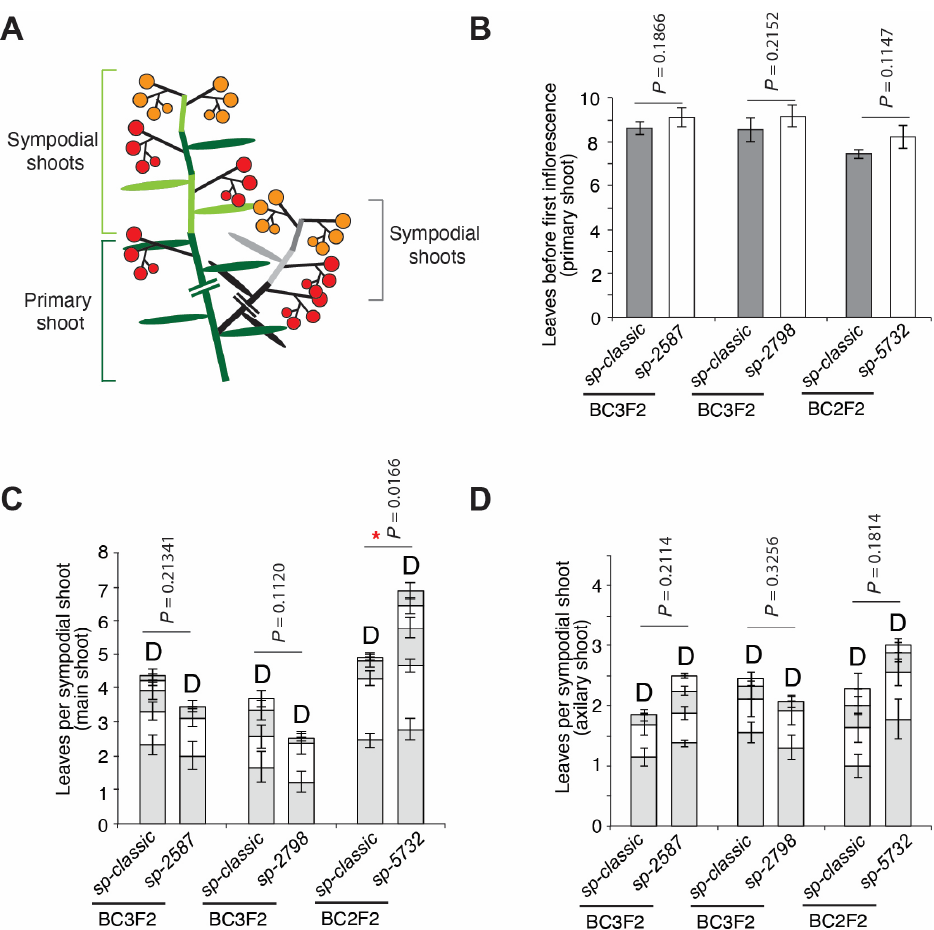
Figure 4. Comparison of flowering time with leaf numbers on the primary and sympodial shoot among sp alleles. ( A ) Diagrams depicting sympodial shoot growth on the main and axillary shoot in determinate tomato. Alternating dark green and light green bars represent the primary and successive sympodial shoots in main shoot. Alternating black and gray bars indicate the successive sympodial shoots in an axillary shoot. Ovals on the colored bars indicate leaves produced in each shoot. Red- and orange-colored circles represent maturing fruits. ( B ) Quantification and comparison of flowering time in the main shoot in three sp mutant alleles. sp-classic segregated from BC2 or BC3F2 generation was used as the control. ( C , D ). Quantification and comparison of leaves produced by five successive sympodial-shoot initially produced by primary shoot ( C ) and by axillary shoot ( D ). Mean values ( ± s.d) of leaves produced by each sympodial shoot (alternative grey and white color bar) were compared to those for sp-classic and sp allele segregated. The sum of the leaves from five sympodial shoots was used to test statistical significance in ( C , D ). D, terminated shoot; p values determined via two-tailed, two-sample t-test; * p value < 0.05.